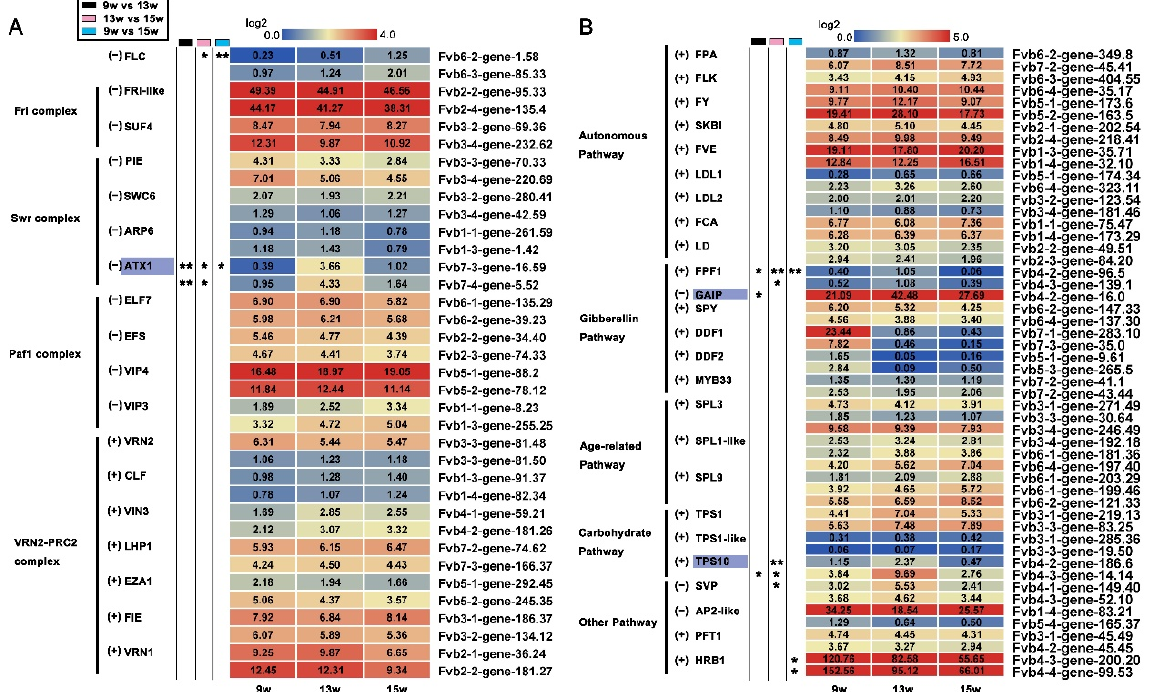
Figure 3. FPKM values of key genes belonging to the different flowering time pathways. ( A ) Heat map showing the expression of genes involved in the vernalization pathway. ( B ) Heat maps showing the expression of genes involved in the autonomous, GA, age-related, carbohydrate, and other pathways. (+) indicates the positive regulators of flower bud differentiation in Arabidopsis, and ( − ) indicates negative regulator. 9 w: vegetative stage, 13 w: shifts to reproductive stage at gene level, 15 w: reproductive stage. The column with the black boxes represents the student’s t test analysis of DEGs at 9 w vs. 13 w; The column with the pink boxes represents the student’s t test analysis of DEGs at 13 w vs. 15 w; The column with the blue boxes represents the student’s t test analysis of DEGs at 9 w vs. 15 w. (* |Log2FC| ≥ 1, p < 0.05. ** |Log2FC| ≥ 2, p < 0.01).